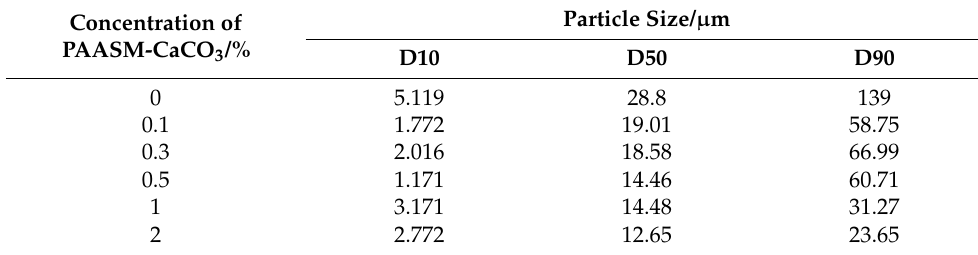
Figure 12. Particle size distribution after aging (in °C/16 hg). Table 6. Partial size value of muds.